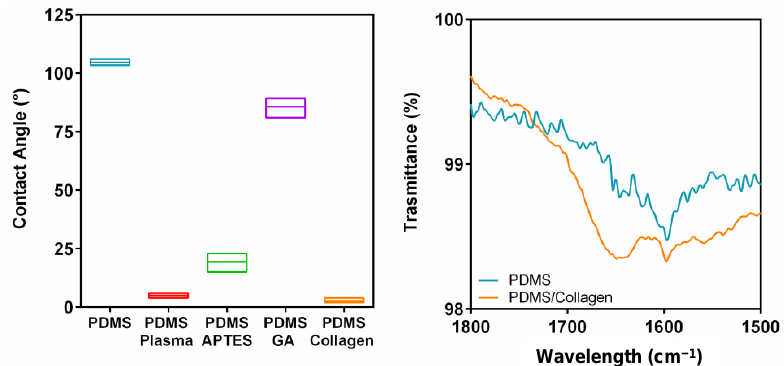
Figure A4. ( Top row ): cLSM micrograph of collagen type I functionalised PDMS films immunostained with mouse monoclonal IgGG1 used as primary antibody and DyLight 488 employed for antibody labelling and prepared at 2000 rpm. Scale bar: 40 µm. SEM micrograph of the collagen type I functionalised PDMS films. Scale bar: 1 µm . ( Bottom row ): Contact angle measurements between each step of the collagen type I functionalisation and FTIR signal between 1800 and 1500 cm −1 confirming the collagen coating by showing the characteristic absorption band of amide I (1650 cm −1 ).